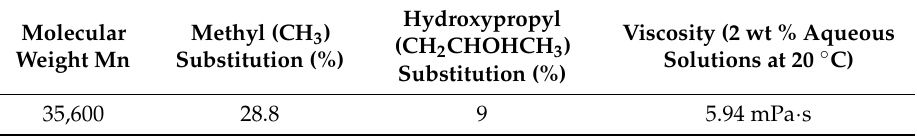
Table 1. Specifications of hydroxypropyl methylcellulose